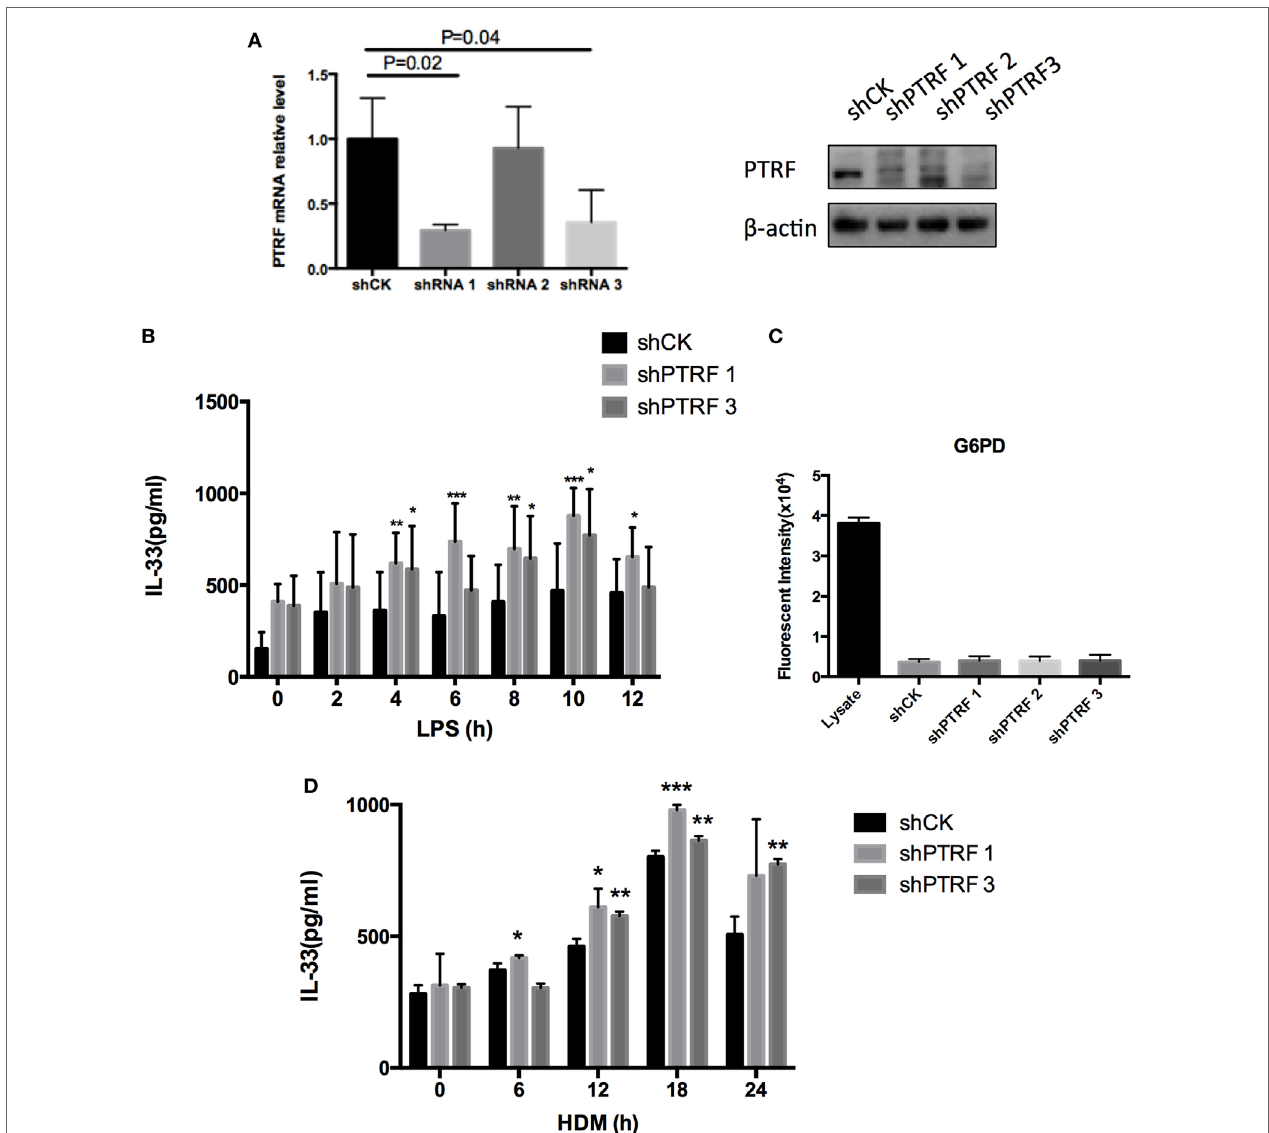
FigUre 4 | Knockdown of polymerase I and transcript release factor (PTRF) induced excessive IL-33 release. (a) Knockdown efficiency of shPTRF. mRNA level of PTRF (left panel) and protein level of PTRF (right panel). (B) IL-33 level in culture supernatant of HBE after LPS (1 ng/µl) treatment. (c) G6PD release assay in HBE with knockdown of shPTRF. (D) IL-33 level in culture supernatant of HBE after HDM (30 µg/µl) treatment. * p < 0.05, ** p < 0.01, *** p < 0.001, as determined by Student’s t